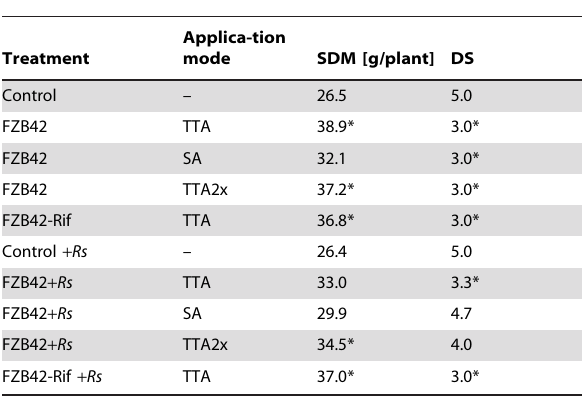
Table 2. Effects of Bacillus amyloliquefaciens FZB42 and FZB42-Rif on lettuce growth at two different experimental conditions: natural pathogen pressure and additional